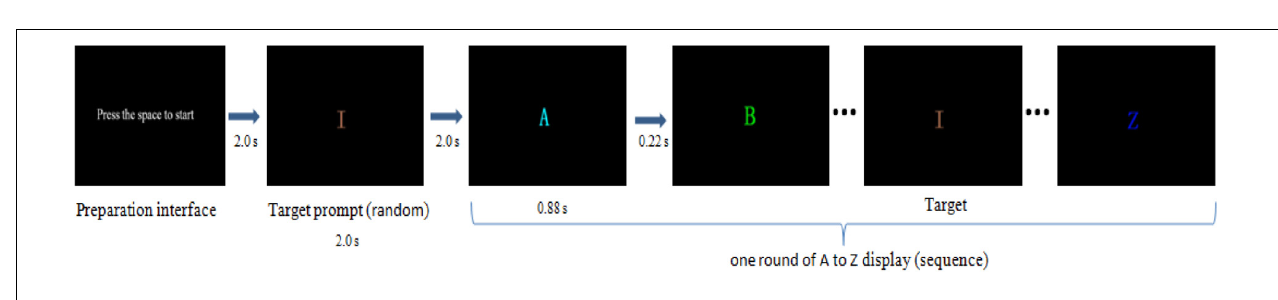
FIGURE 3 | The image-based RSVP framework for experiment.